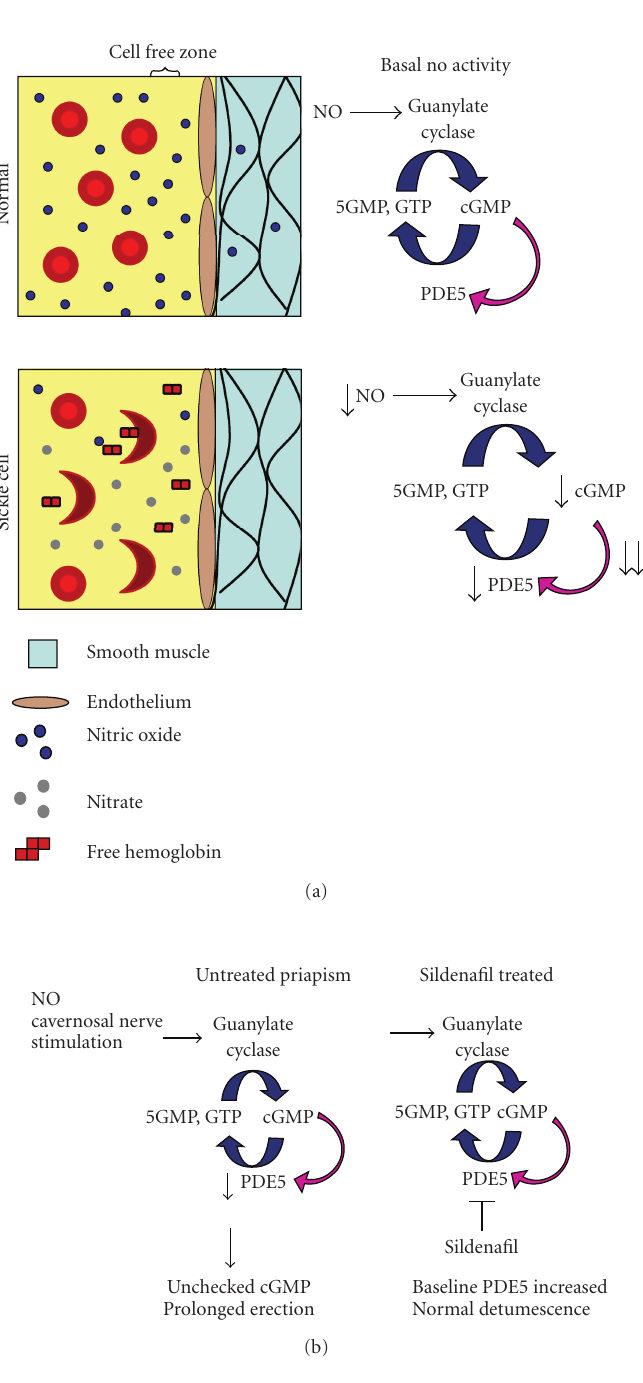
Figure 1: Abnormal nitric oxide signaling leads to priapism in SCD. NO can be readily scavenged by free hemoglobin and deactivated by conversion to nitrate. This is normally prevented by compartmentalization of hemoglobin in red cells and a cell free zone adjacent to the endothelium ((a), first panel adapted from Liao [9] and Rother et al. [23]). In SCD, chronic hemolysis leads to higher levels of free hemoglobin and decreased NO availability. This results in decreased basal levels of its downstream e ff ector, cGMP, and decreased PDE5, which degrades cGMP. Following cavernosal nerve stimulation in SCD (b), normal levels of cGMP are achieved as NO is released from nerve terminals. However, PDE5 levels remain low, leading to prolonged cGMP activity and prolonged erection. This can be prevented by long-term treatment with sildenafil ((b), second panel). Inhibition of PDE5 by sildenafil results in increased cGMP, which then increases basal PDE5 levels through normal feedback mechanisms [13,